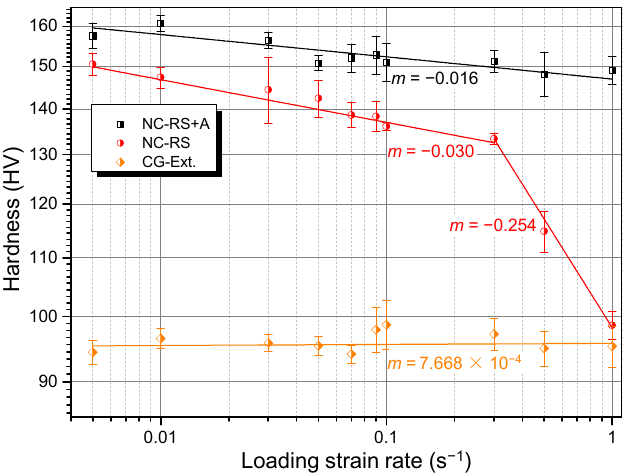
Figure 6. Room temperature strain rate sensitivity of NC and CG Mg–Gd–Y–Zr alloys. For materials with specific texture, the change of loading direction may influence their dominant deformation modes, which would therefore result in the variation of SRS.